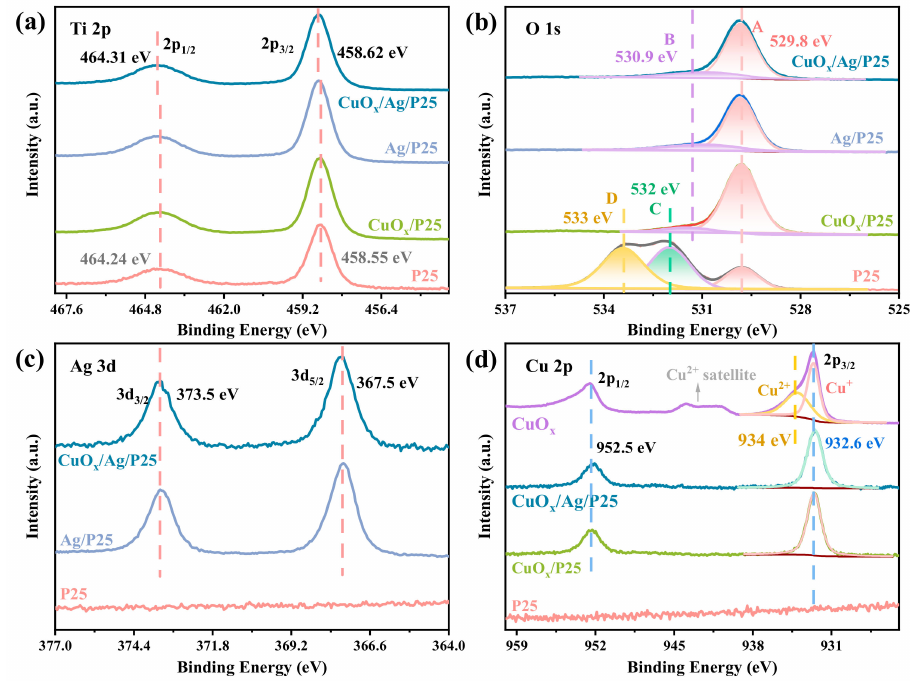
Figure 2. XPS spectra of the samples: ( a ) Ti 2p, ( b ) O 1s, ( c ) Ag 3d, and ( d ) Cu